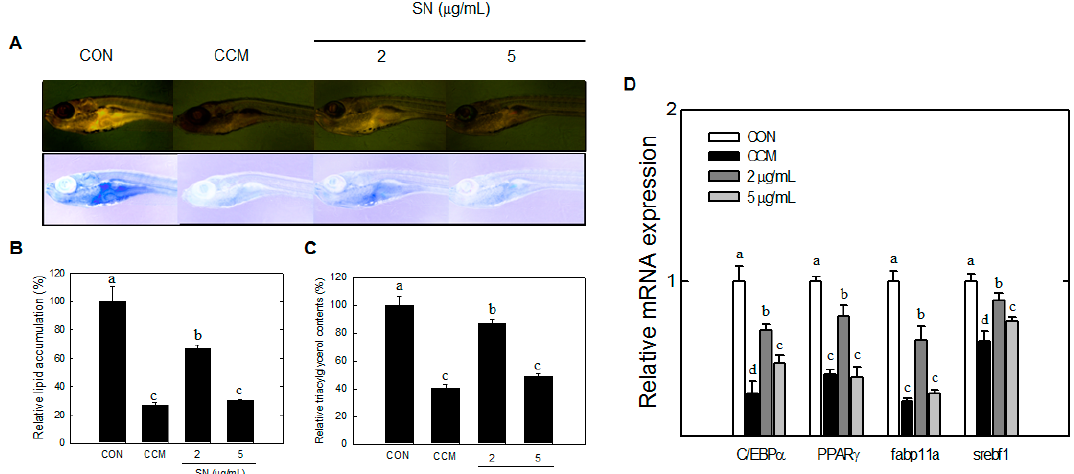
Figure 8. Effects of SN on lipid accumulation in zebrafish. ( A ) Live larvae were visualized under a fluorescence microscope, and the image color was inverted; ( B ) Fluorescence microscopy image were quantified by using ImageJ software; ( C ) Triglyceride levels in zebrafish were determined using a TG Assay Kit (Zen Bio, Inc.); ( D ) mRNA expression of adipogenic factors in zebrafish was quantified by qRT-PCR. CON: high fat diet, CCM: curcumin, SN: seapolynol. Data are presented as means ± SD of 20 zebrafish. All data are representative of three replicates. Means not designated by a common superscript are significantly different ( p < 0.05).